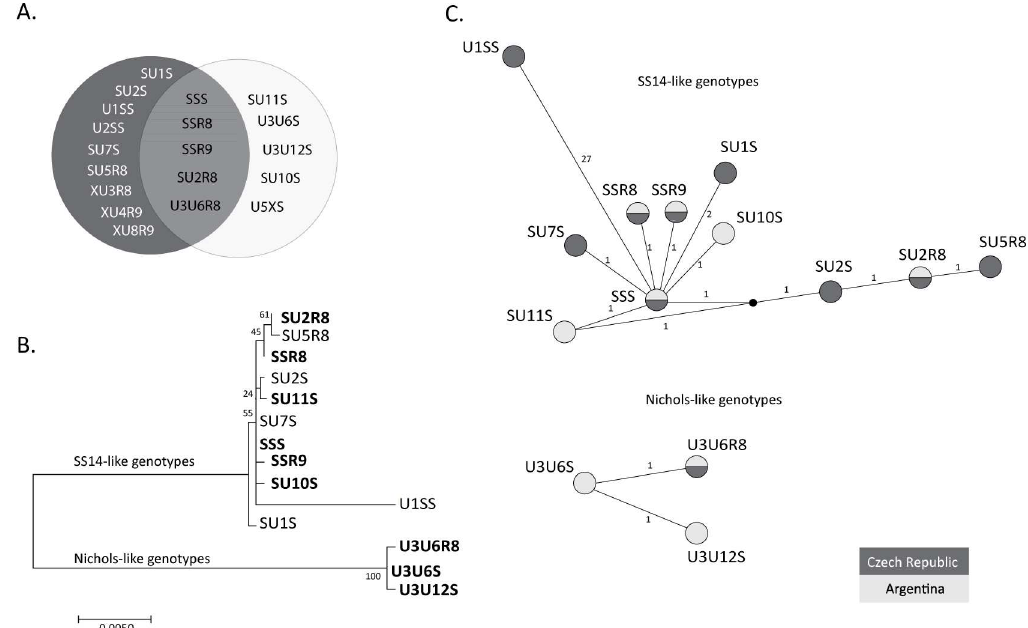
Fig 4. Genotypes identified using SBMT to date in the Czech Republic and in Argentina [this study, 14, 15] and their phylogenetic and network analyses. A. Genotypes identifiedexclusively in the Czech Republic(dark grey background), in Argentina(light grey background) and in both locations.Both fully and partiallytyped genotypes are shown. B. The phylogenetic tree of concatenated sequencesof TP0136, TP0548, and 23S rRNA. Partially typed genotypes(XU8R9, XU3R8, XU4R9, and U5XS) were excluded.The U2SS genotypeis also not shown due to the short sequenceobtainedfrom the TP0136 gene. Genotypes identified in this study are shown in bold. The bar scale represents 0.005 substitutionsper target site. The numbers at each node correspondto bootstrap values. C. The network tree of concatenated sequences of TP0136,TP0548, and 23S rRNA genes.Partiallytyped genotypes (XU8R9,XU3R8, XU4R9and U5XS) were excluded. The U2SS genotypeis alsonot showndue to the short sequence obtainedfrom the TP0136gene. Every circle represents a different genotype. The small numbersrepresentthe phylogenetic distances betweengenotypes.The blackcircle represents an unknownancestor. Genotypesidentifiedin the Czech Republicand in Argentina are shownin dark andlight grey, respectively.